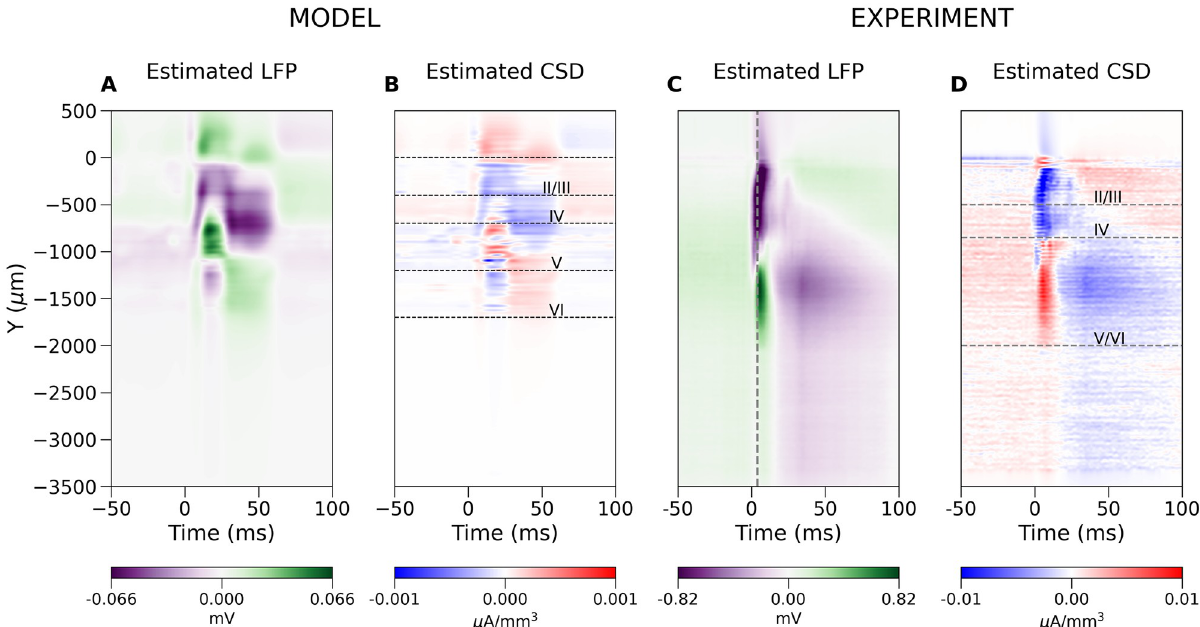
Fig 3. A. LFP and B. CSD within the model column as a function of time. Horizontal lines indicate position of the layers according to the model definition, which defines distribution of cell bodies. Corresponding C. LFP and D. CSD in actual experiment using Neuropixels probe in rat barrel cortex. Dashed vertical line in C marks the time snapshot where Fig 4 is